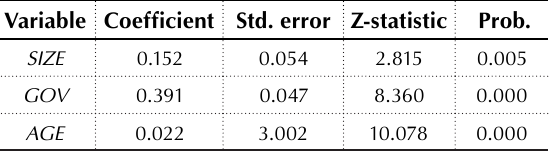
Table 4. Results of calculating business performance of banks in model 2 Source: Results analysis based on DEAP 2.1. Table 5. Tobit regression result Source: Results analysis based on Eview 10.0. Variable Coefficient Std. error Z-statistic